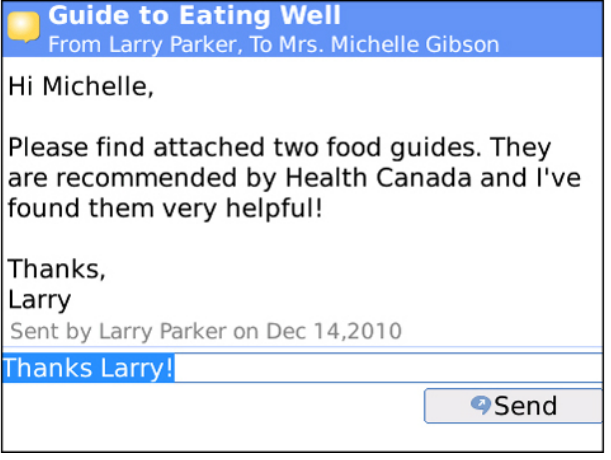
Figure 10. Messaging allows for two-way secure messaging between participant and health coach who can selectively promote healthy choices at pivotal times of client decision-making, providing support immediately after healthy behaviors have been logged, and/or addressing questions and/or sending relevant materials.